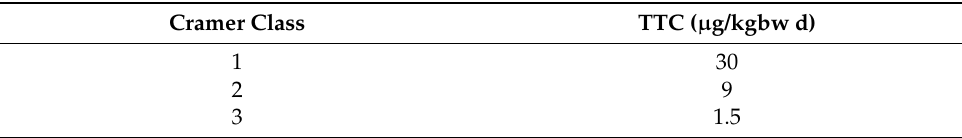
Table 7. Cramer classes and related TTC